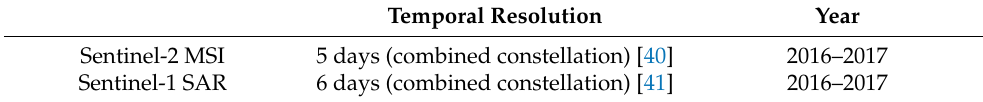
Table 4. Temporal resolution and collection time of the modalities in